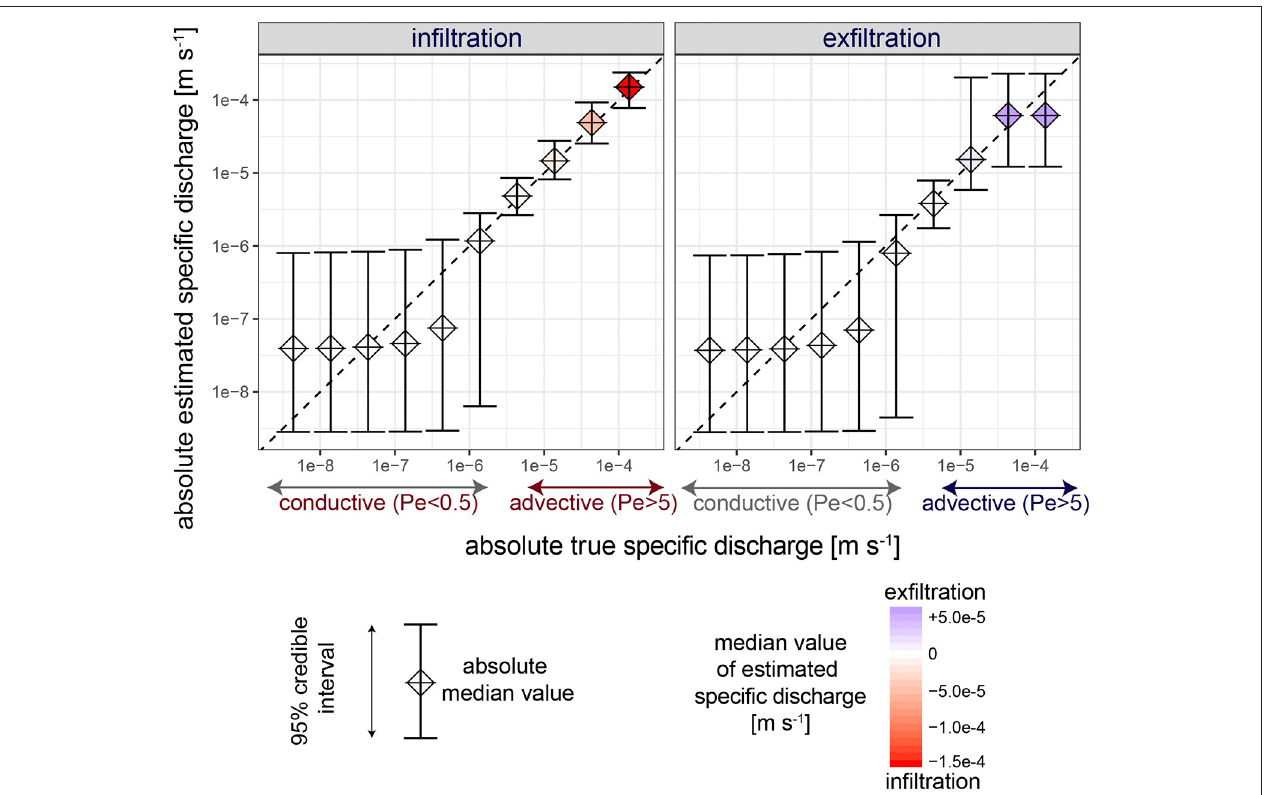
FIGURE 5 | Statistics of estimated specific discharge: median and 95% posterior credible intervals, Pe ∈ [0.01,100]. Axes are on the logarithmic scale. Specific discharge is identifiable above 2 · 10 − 6 m s − 1 (17 cm d − 1 ), where the width of the 95% posterior credible interval ranges over half an order of